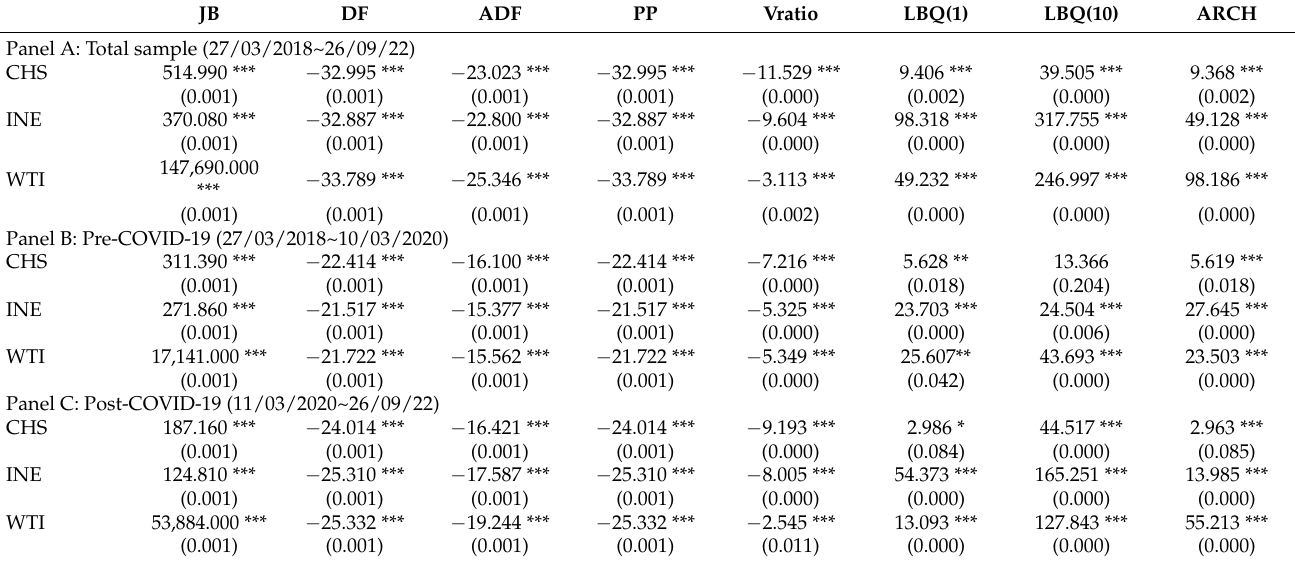
Table 2. Basic statistical